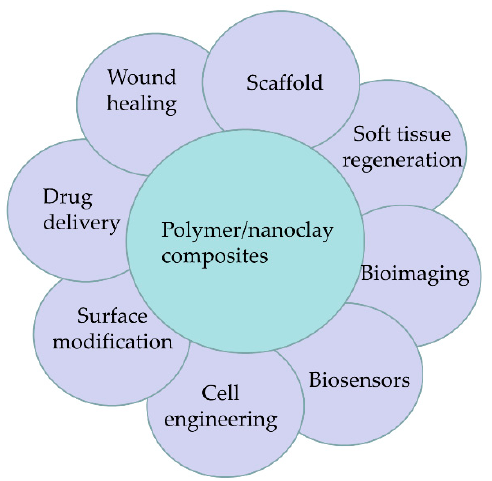
Figure 6. Various biomedical applications of polymer/nanoclay composites.